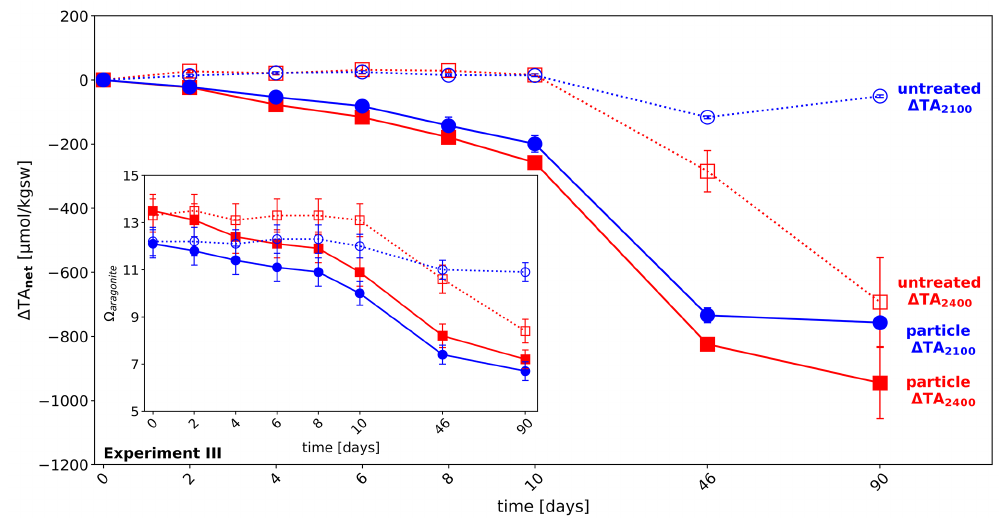
Figure 4. Long-term stability of added alkalinity in the CO 2 -equilibrated approach: development of alkalinity loss ( (cid:49) TA loss ) over time in the two highest alkalinity treatments of experiment I, (cid:49) TA 2400 (red) and (cid:49) TA 2100 (blue), in untreated mode (dotted lines), and with particle addition (solid line) over time. Insert: development of (cid:127) aragonite in the above treatments. Error bars denote the standard deviations of two measures, except for untreated (cid:49) TA 2100 where only one measurement was taken due to technical